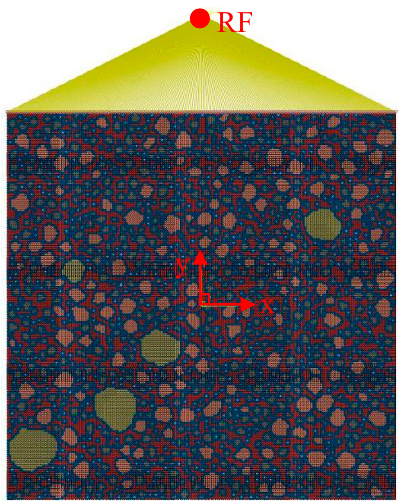
Figure 9. 2D RPA model with coupling constraints.